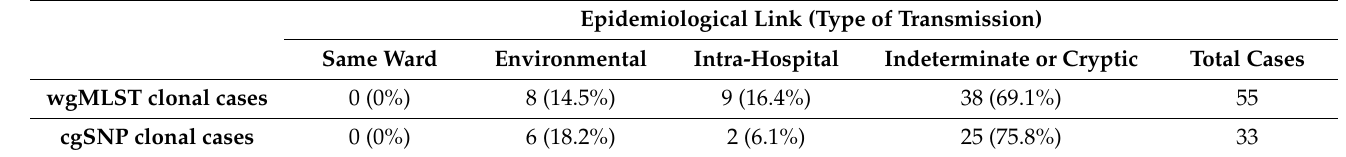
Table 2. Epidemiological links among CDIs due to isolates belonging to clonal complexes. Epidemiological Link (Type of Transmission) Same Ward Environmental Intra-Hospital Indeterminate or Cryptic Total